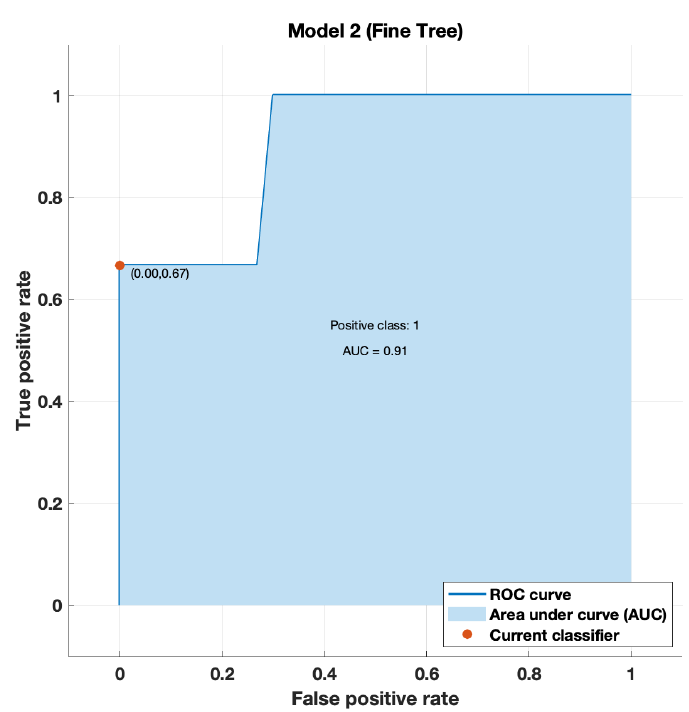
Figure 12. ROC curve of processed